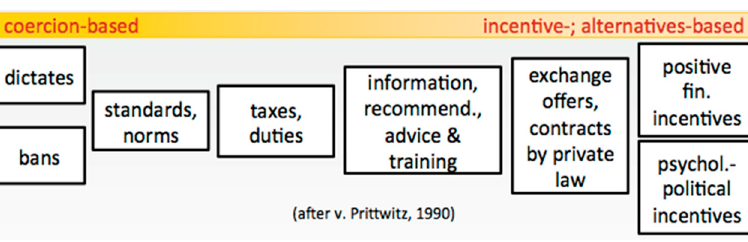
Figure 1. Regulating relationships—a diversity of options and combinations. Forests 2020 , 11 , 168